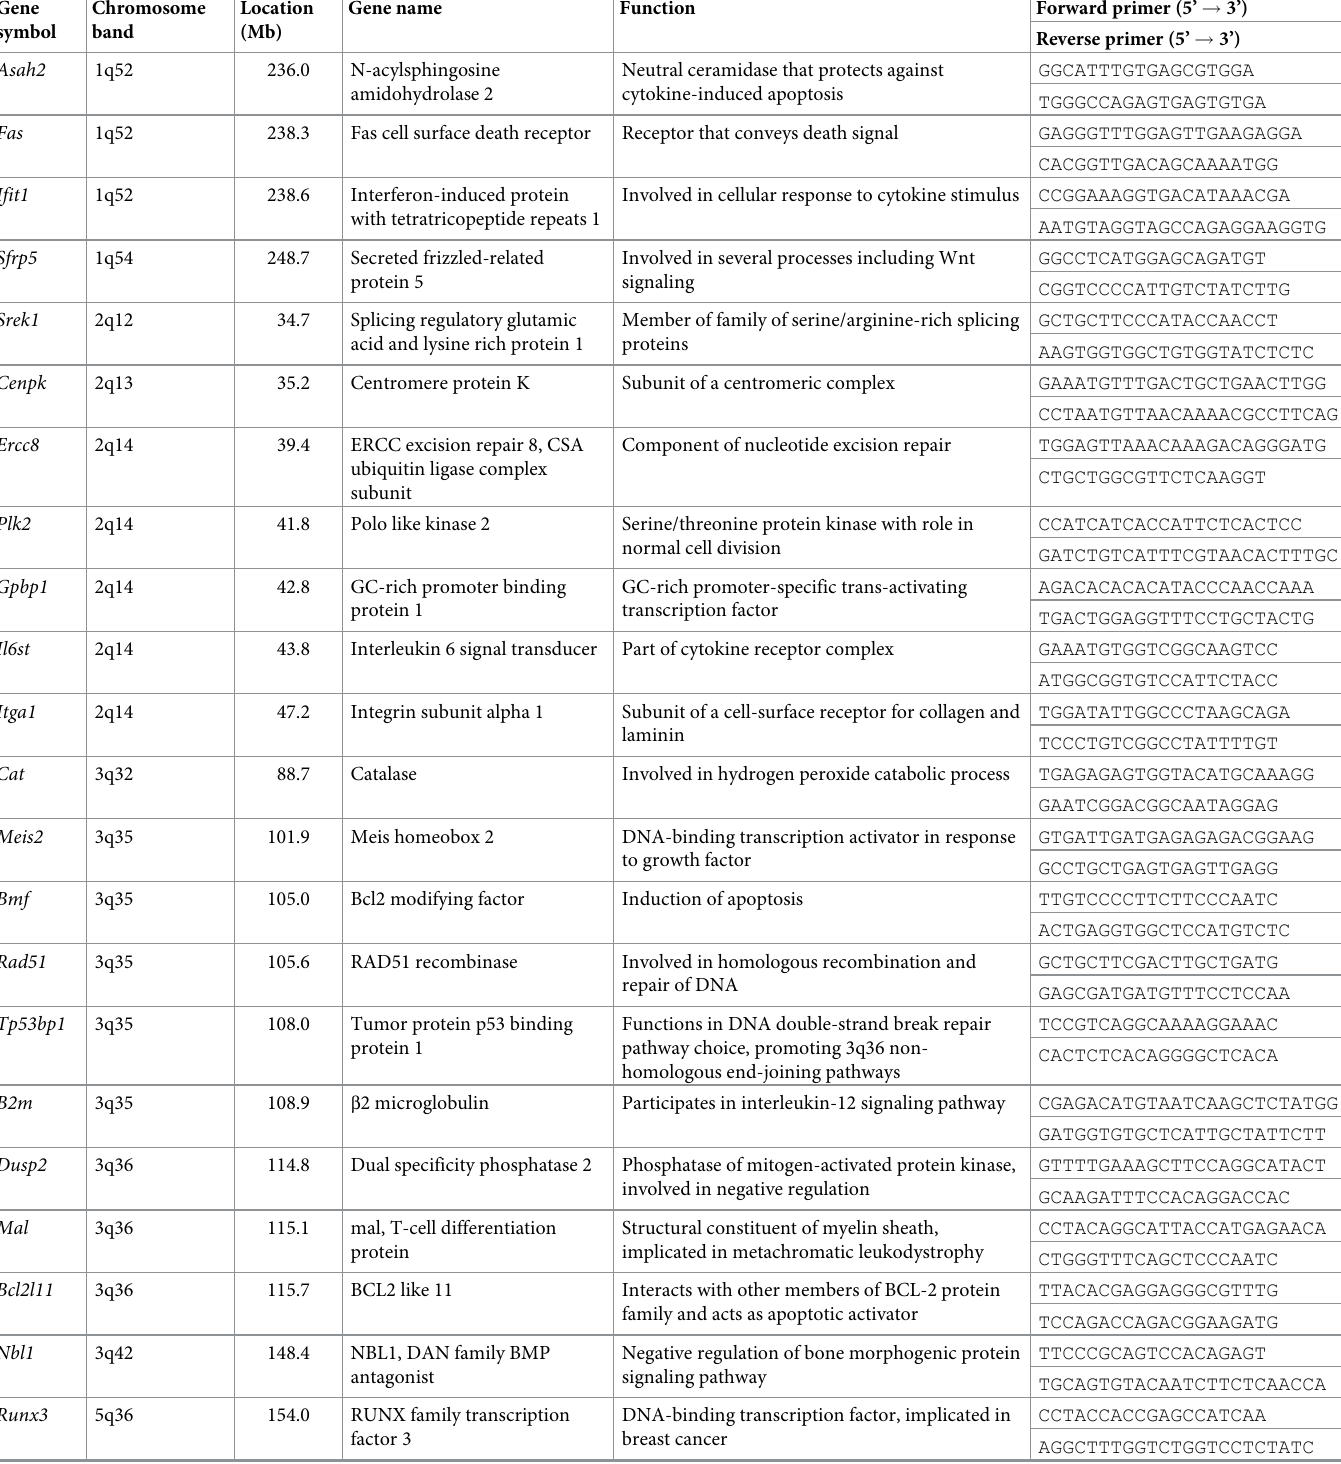
Table 1. Genes and primers for quantitative